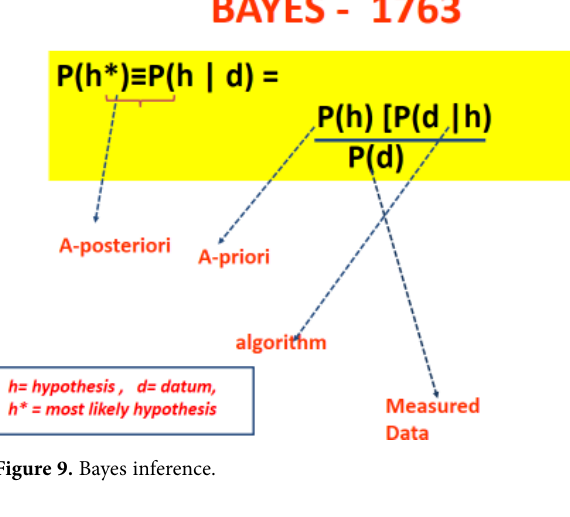
Figure 9. Bayes inference.